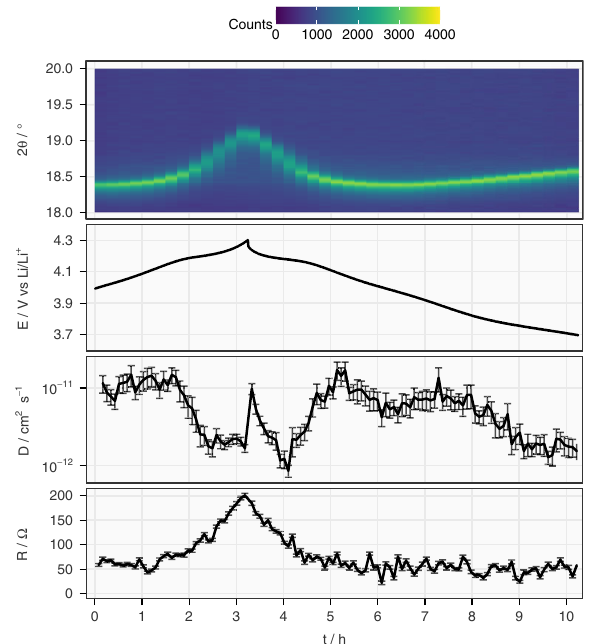
Fig.8|ResultsfromoperandoX-raydiffractioncombinedwiththeICImethod. The evolution of the 003 ( fi rst panel) re fl ections (Cu-K α 1 ) as a heat map, electrode potential (E), Li-ion diffusion coef fi cient in NMC811 ( D ) and the internal resistance (R)fromthecombinationofoperandoXRDandtheICImethodconductedonCell1 after56galvanostaticcyclesbetween3.0and4.3Vandthe57thchargeto4.0V.The incompletecycledoesnotaffecttheobservationofthecorrelationbetweentheLi- ion diffusivity and the structural change above 4.2V. The error bars of D and R originate from the standard deviation of linear